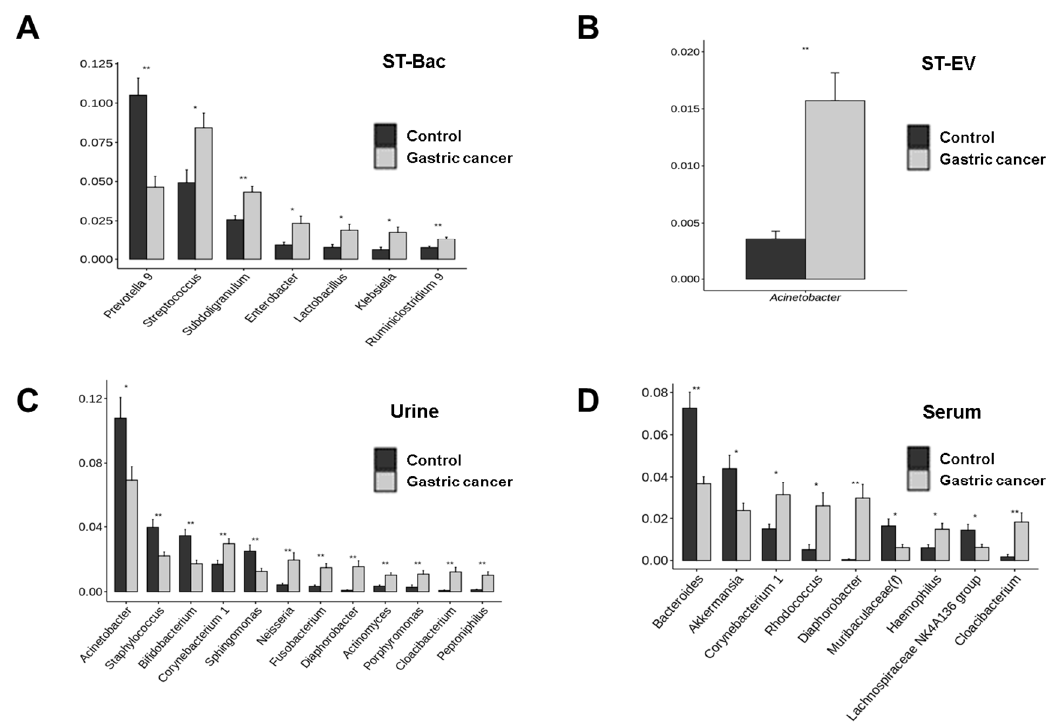
Figure 5. Compositional differences in genus level between healthy controls and gastric cancer patients in 4 sample types. The bar plots highlight the average relative abundance of individual key taxa between the two groups ( A ) in stool bacteria (ST-Bac) isolated from stool pellet, ( B ) in stool-derived extracellular vesicle (ST-EV) isolated from stool supernatant, ( C ) in urine, and ( D ) in serum. *, p < 0.05; **, p < 0.01.